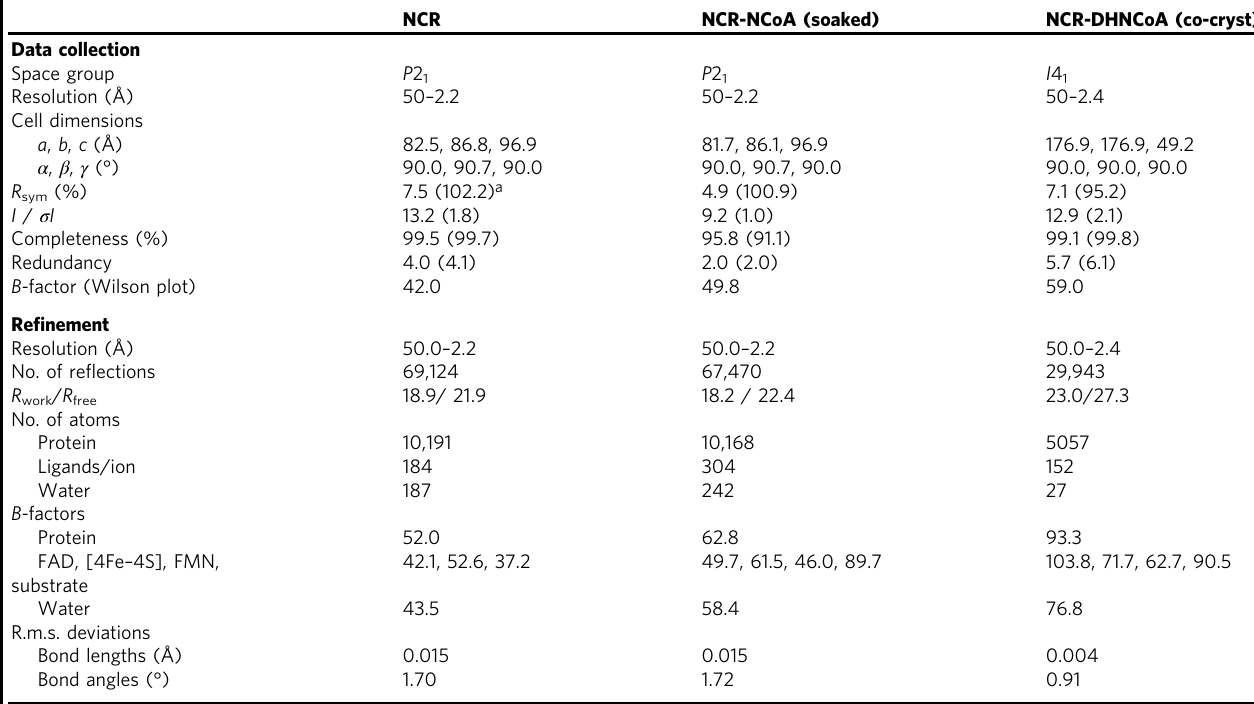
Table 1 Data collection and re fi nement statistics